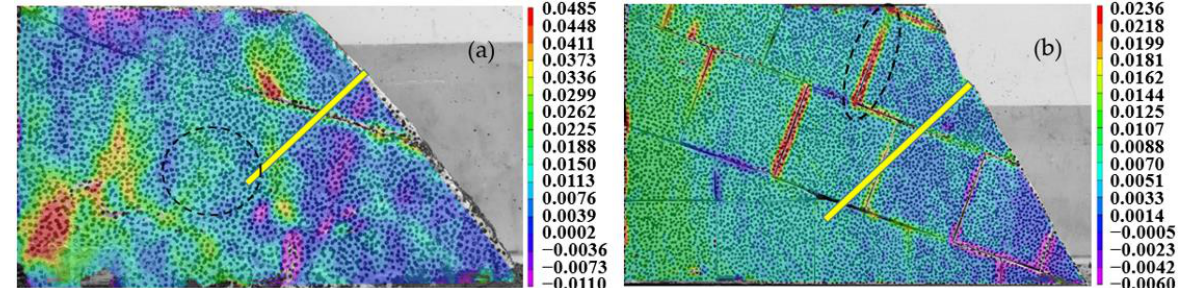
Figure 14. Strain contours of the slope model after reinforcement under loading and irrigation. ( a ) One crack at 20°; ( b ) crack networks at 20°.